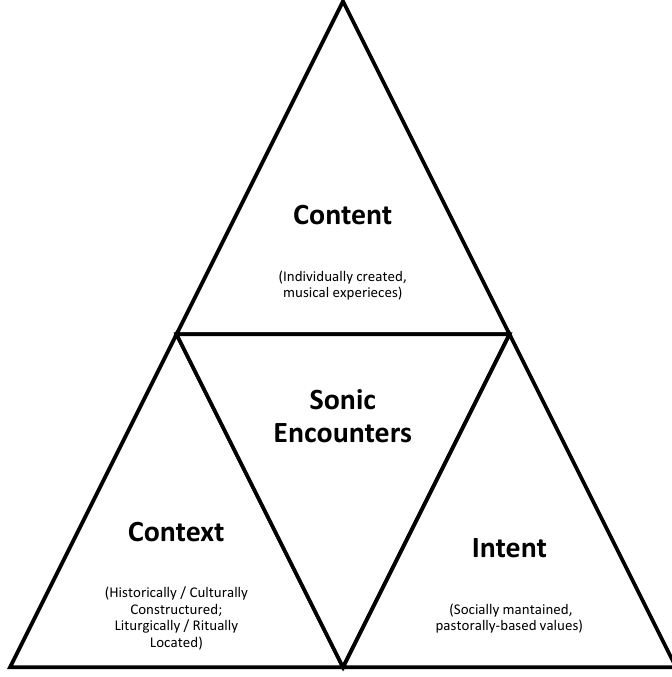
Figure 1. A Three-fold Model of Sonic Encounter.